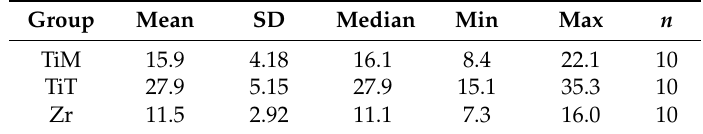
Table 2. Comparison of the maximum removal torque (N cm) between the groups.